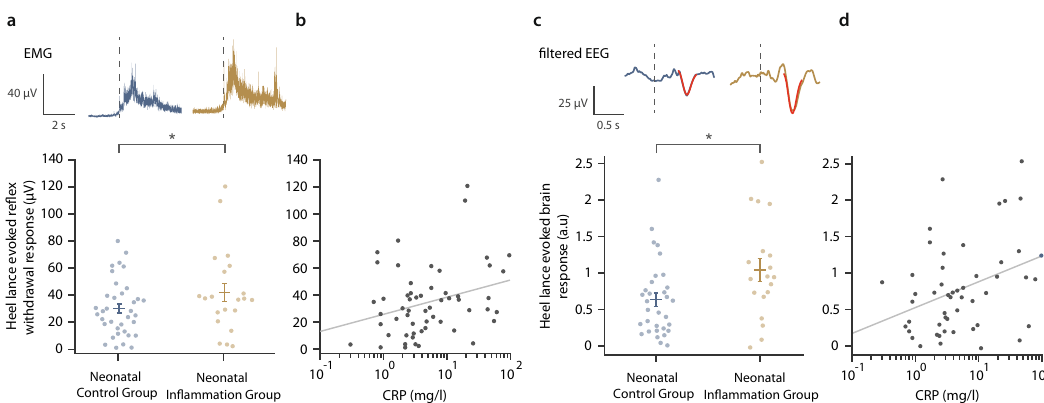
Fig. 2 In fl ammation is associated with increased spinal cord excitability and hyperalgesia during a noxious procedure in neonates. a (Top) Average electromyography (EMG) traces during a clinically required heel lance for participants in the Neonatal Control Group (blue, n = 36) and Neonatal In fl ammation Group (gold, n = 21, CRP > 10 mg/l or presented evidence of infection). (Bottom) Root mean square (RMS) of the re fl ex withdrawal in the limb ipsilateral to the stimulus site in the two groups. The difference between groups was assessed using a two-sample, one-sided t test, t = 1.74, * p = 0.048 (corrected using Holm ’ s method). b Relationship between the CRP level at the time of the study and the magnitude of the re fl ex withdrawal following a clinically required heel lance ( n = 57, Pearson correlation r = 0.28, one-sided p = 0.028). c (Top) Group average Woody fi ltered electroencephalography (EEG) traces in response to the clinically required heel lance; Neonatal Control Group ( n = 32) and Neonatal In fl ammation Group ( n = 19). The template of noxious-evoked brain activity 38 is shown overlaid in red. (Bottom) Magnitude of the noxious-evoked brain activity following heel lancing in the two groups. The difference between groups was assessed using a two-sample, one-sided t test, t = 2.4, * p = 0.022 (corrected using Holm ’ s method). d Relationship between the CRP level at the time of the study and the magnitude of the noxious-evoked brain activity following a clinically required heel lance ( n = 51, Pearson correlation r = 0.31, one-sided p = 0.023). a , c dashed lines indicate the point of stimulation, and error bars indicate mean ± standard error, in b and d , solid line indicates the line of best fi t. a.u: arbitrary units. Source data are provided as a Source Data fi le.